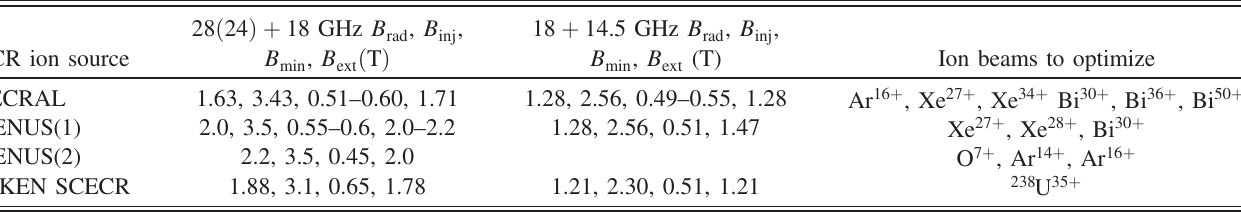
TABLE IV. Comparison of the optimized magnetic fields among SECRAL, VENUS and RIKEN-SCECR.